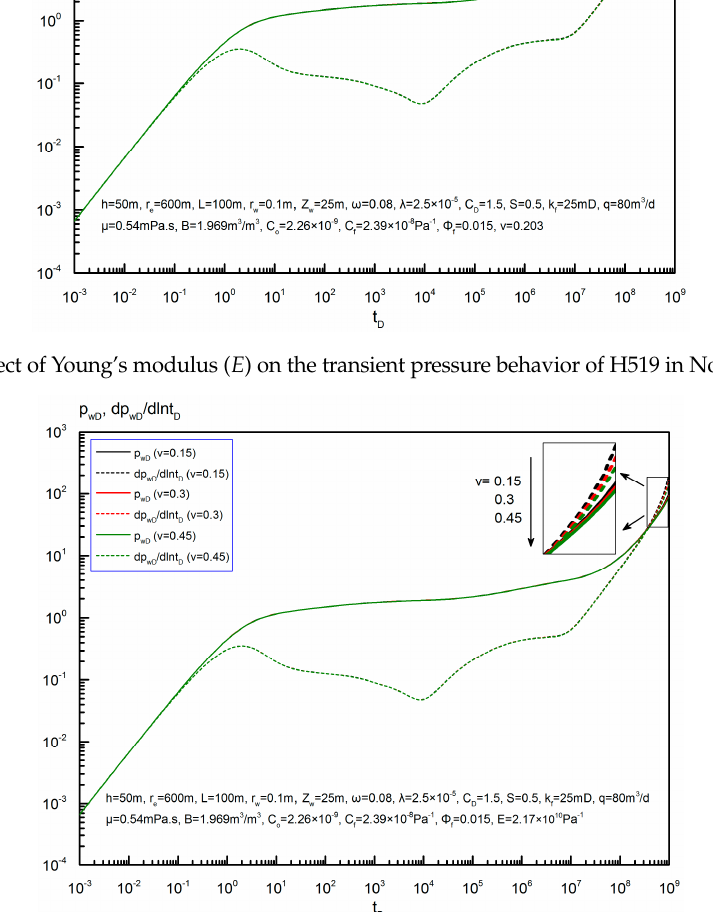
Figure 15. Effect of Poisson’s ratio ( ν ) on the transient pressure behavior of H519 in North Truva field.